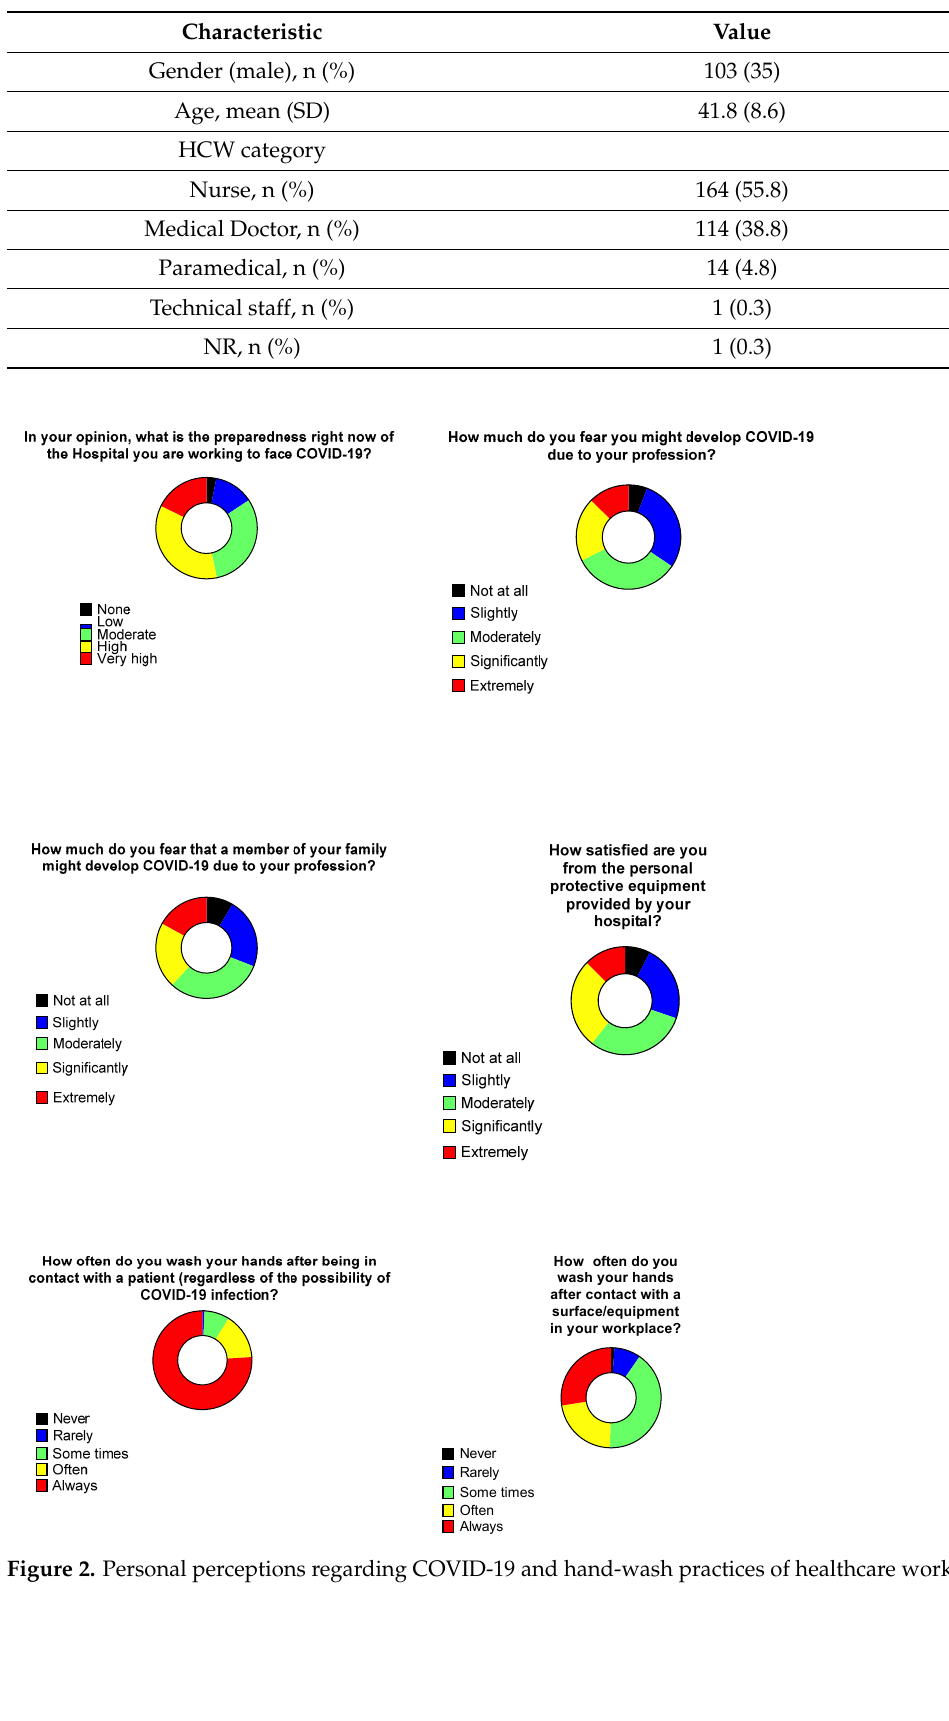
Table 1. Participants’ characteristics. NR: not reported; SD: standard deviation.